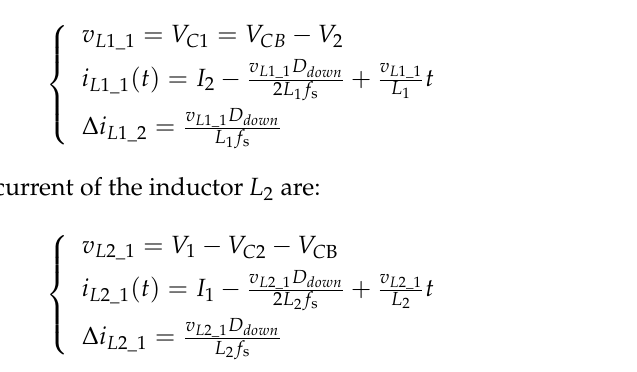
Figure 6. The operation waveforms of main components in step-down mode. Mode 1 ( t 1 – t 2 ): The equivalent operating circuit in this stage is shown in Figure 5a. At the moment of t 1 , S 2 and D B1 are turned on, capacitor C 1 charges inductor L 1 . The high-voltage side V 1 charges capacitor C 2 , L 1 , L 2 and the low-voltage side. Capacitor C B supplies the low-voltage side and L 1 . The inductor current reaches its maximum value until mo- ment t 2 . In this mode, the voltage and current of the inductor L 1 are: